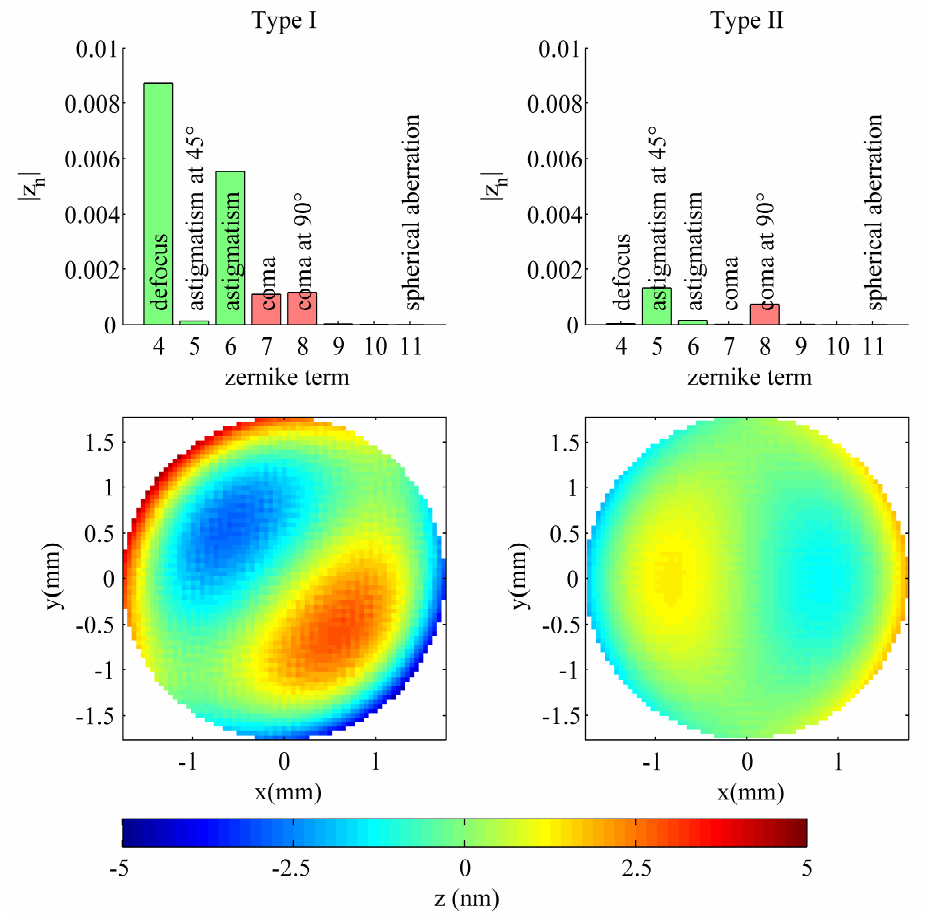
Figure 12. Analysis of ray-tracing results from the compensated Type I system with five round-trips and the compensated Type II system with 10 round-trips. The upper diagrams show the Zernike coefficients of the output wave front (numbering according to Noll et al. [9]) for a wavelength corresponding to 1µm. The lower images show the corresponding residual wavefront after subtracting all terms lower than